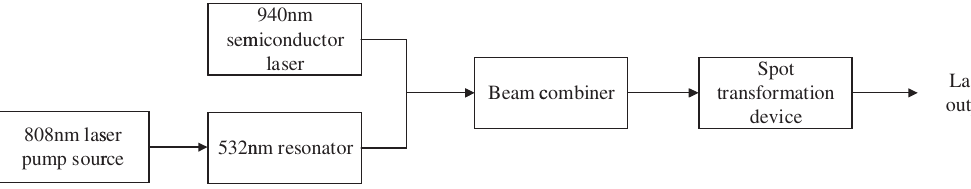
Fig. 1. Schematic of the optical system of the dual-wavelength high-power laser therapy